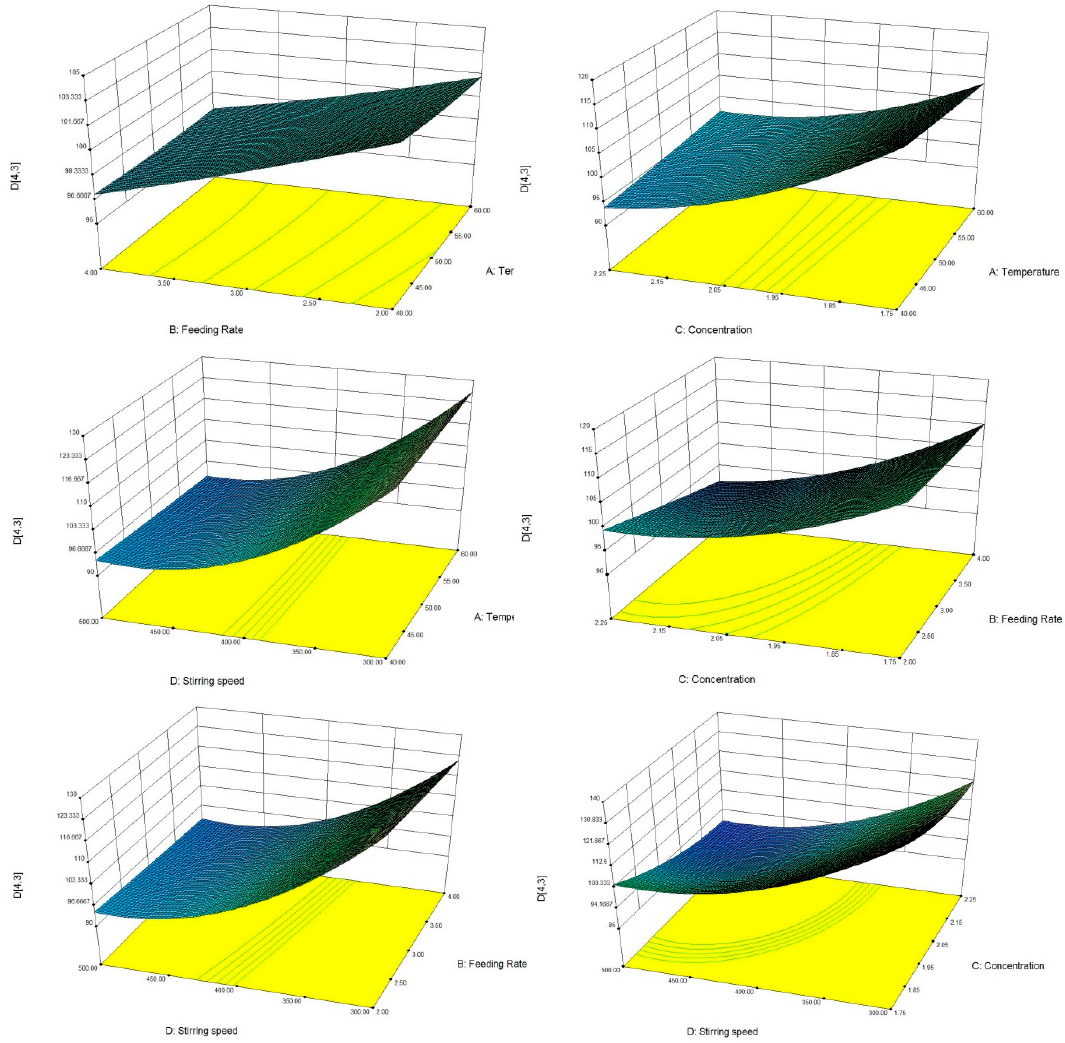
Figure 7. 3D surface plots of effects of binary interactions among factors A (temperature), B (feeding rate), C (concentration), and D (stirring speed) on response value Y 2 (particle size of Li 2 CO 3 ).